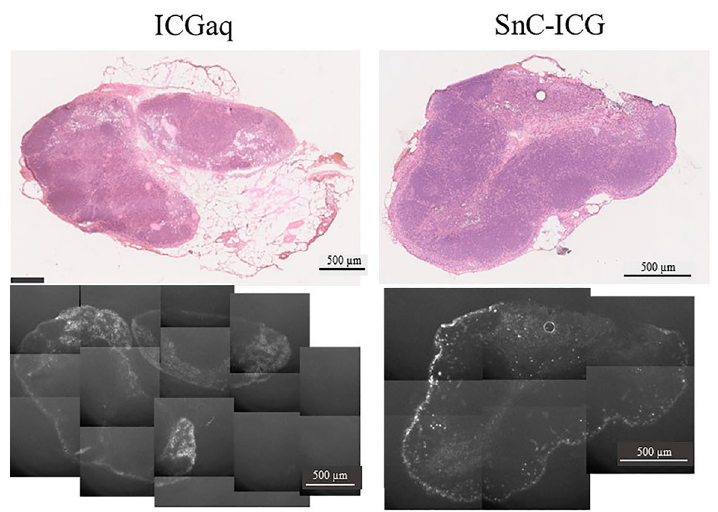
Figure 3. Histological findings of popliteal lymph nodes (LNs) from rats administered indocyanine green aqueous solution (ICGaq) or stannous colloid/indocyanine green mixed tracer (SnC–ICG). Bright-field images of frozen sections stained with hematoxylin–eosin are shown in the upper row, while near-infrared fluorescence images of the unstained section are shown in the lower